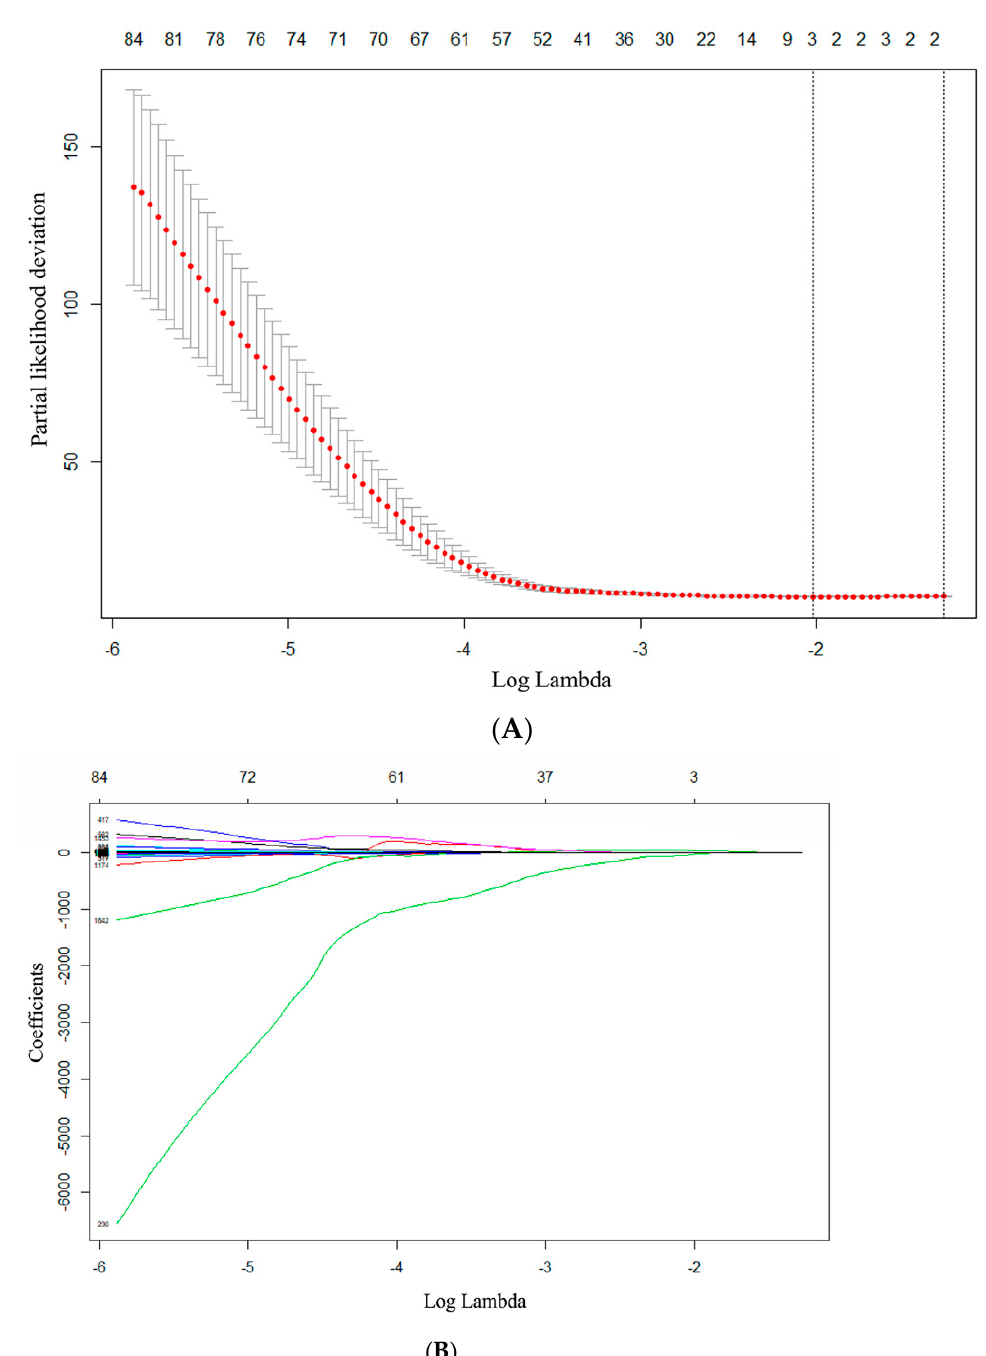
Figure 2. The radiomics features were screened based on lasso-Cox model. ( A ) The minimum criteria for 10-fold cross-validation was used to select optimal features. ( B ) Lasso coefficient analysis of 1702 radiomics features. Each curve in the graph represents the change track of each independent variable coefficient. With the increase of lambda, the coefficients of each feature are gradually compressed and tend to zero. The upper horizontal axis represents the characteristic number of radiomics, the lower horizontal axis represents the penalty coefficient log (lambda), the left vertical line represents the characteristic parameter values corresponding to the minimum partial likelihood deviation in the cross validation, and the right vertical line represents the corresponding parameter values within a standard error.